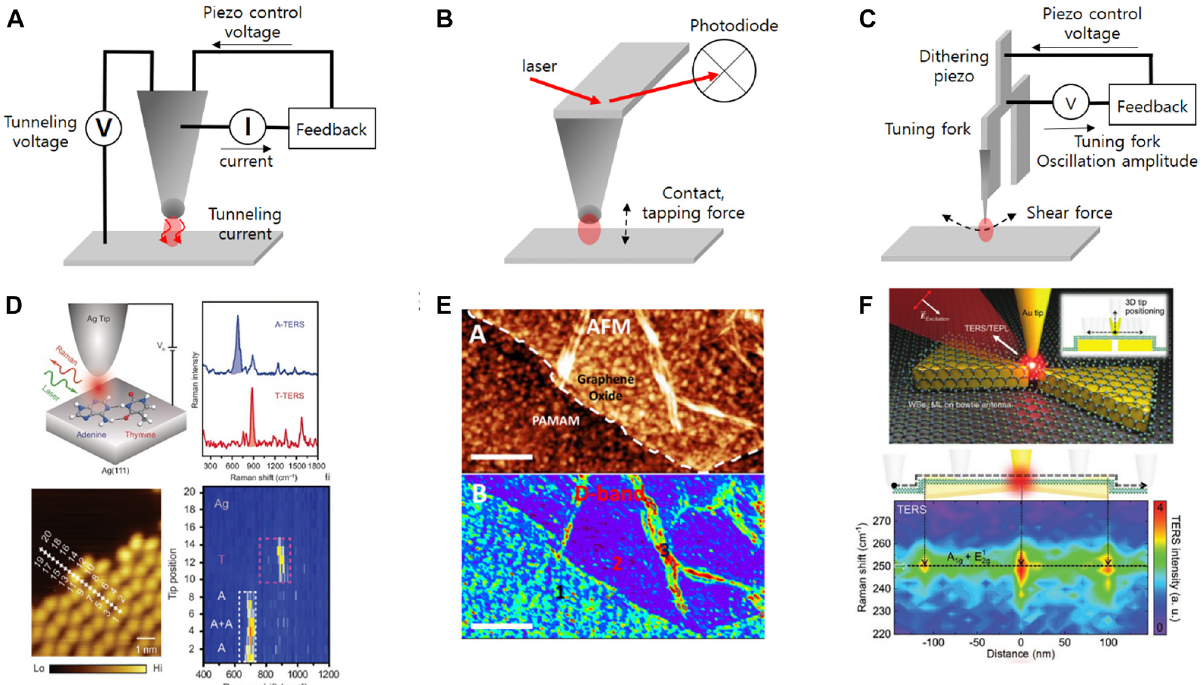
Figure 13: Tip based zerogap (TZ) geometries depending on feedback mechanism for tip-sample surface distance control. (A) TZ of tunneling current feedback controlled STM probe. (B) TZ of AFM controlled by cantilever deflection magnitude feedback mechanism. Thecantileverdeflectionismonitoredbylaserintensityreflectedfromcantilevertopsurface.(C)TZofshear-forcefeedbackcontrolledmetallic probe. (D) Single strand DNA sequencing demonstrated by STM based TERS [139]. (E) Hyperspectral Raman image of Graphene 2D material obtained by AFM based TERS [140]. (F) Local excitation of exciton of TMD 2D material coupled to bowtie nanostructure and shear-force controlled metallic tip probe